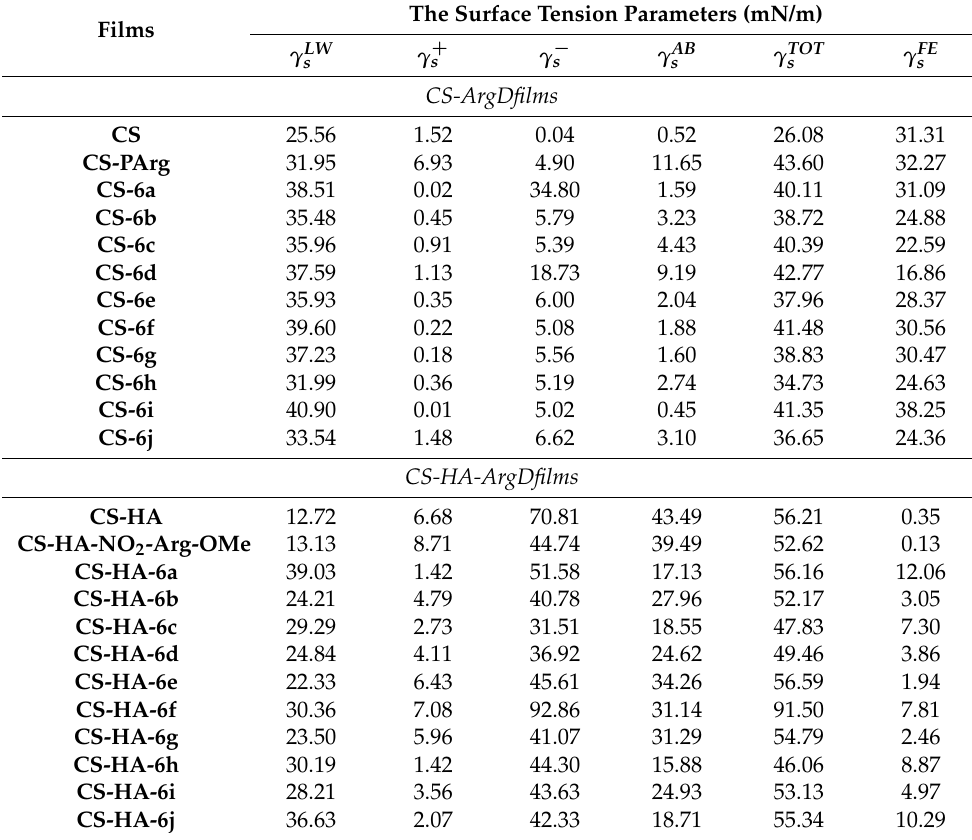
Table 2. The surface tension parameters (mN/m) for CS-ArgD andfor CS-HA-ArgDfilms. The Surface Tension Parameters Films